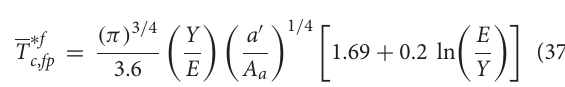
1.5 and G * 2 10 − 7 , and (B) = = × 0.15 ( Wang and =